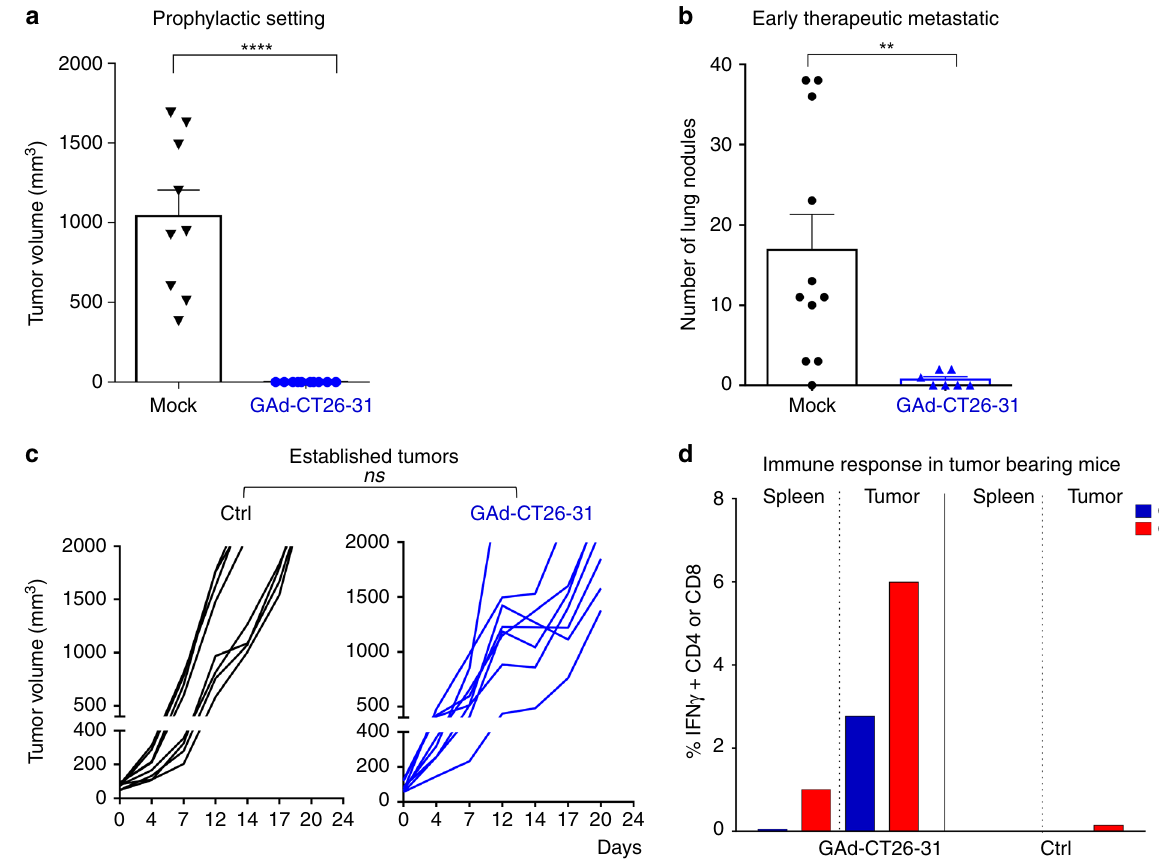
Fig. 2 Early vaccination with GAd effectively controls tumor growth. a Mice ( n = 8 – 10/group) were vaccinated with GAd-CT26-31; 2 weeks after immunization, CT26 cells were injected s.c. and tumor growth was monitored over time. Tumor volume measured 28 days post inoculation in GAd versus untreated (mock) mice is shown (two-tailed Mann – Whitney U test; **** p < 0.0001). b Mice ( n = 8 – 10/group) were inoculated i.v. with CT26 cells (day 0) and left untreated (mock) or vaccinated with GAd-CT26-31 at day 3. The number of lung nodules counted at day 16 is shown (two-tailed Mann – Whitney U test; ** p < 0.01). c Treatment with GAd vaccine started at day 0, on mice randomized according to tumor volume (mean 70 – 100 mm 3 , n = 8/group). Tumor volumes determined over time for individual tumors are shown. (n.s., not signi fi cant by two-tailed Mann – Whitney U test). d For analysis of immune responses in mice with established tumors, TIL or splenocytes were isolated from untreated or GAd-CT26-31-vaccinated groups and pooled ( n = 4). The percentages of IFN- γ + CD4 + or CD8 + T cells measured upon peptides pool re-stimulation are shown. Data from a to d are representative of 2 –